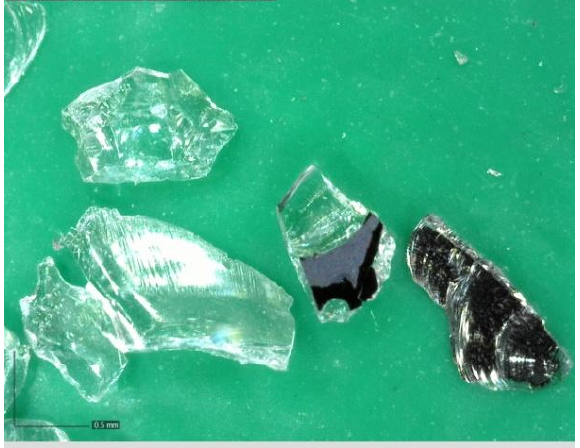
Figure 2. Glass recyclate fraction 0.5/1 mm; 103× magnified.